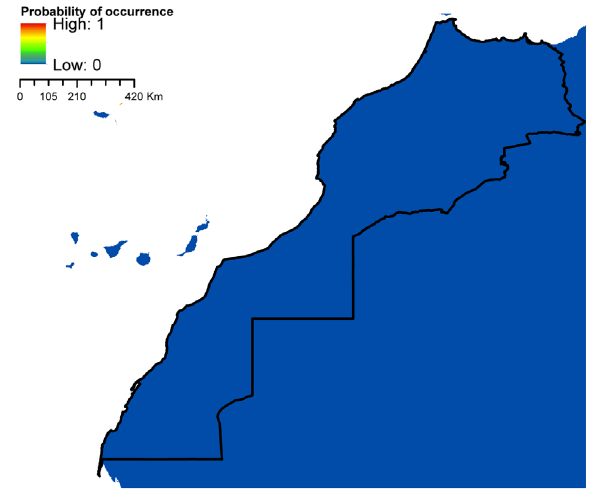
Figure 7. Predicted probability of Ae. vittatus occurrence in Morocco.